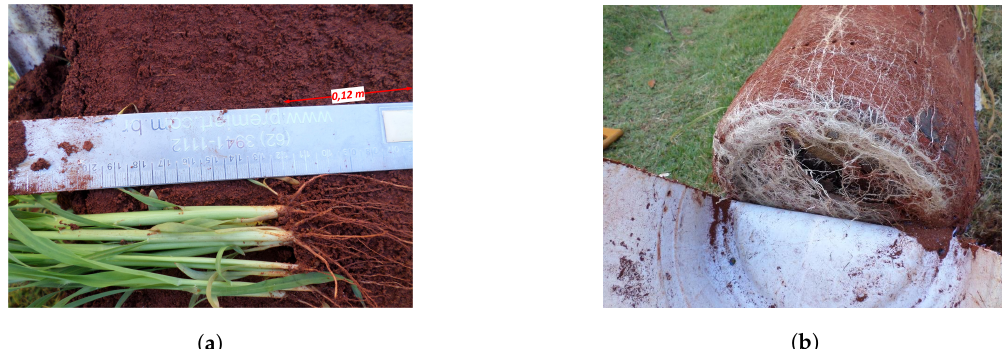
Figure 15. Root growth mapping: (a) start of experiment on the seventh day and (b) end of experiment to the seventy-fourth day.